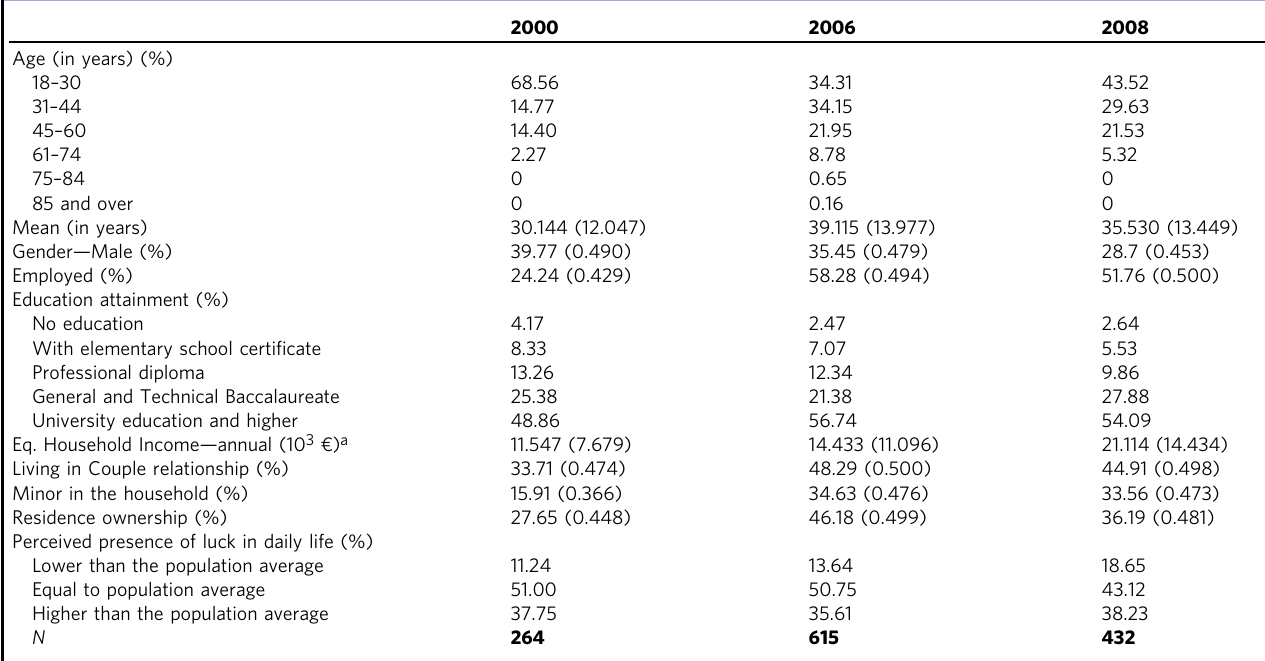
Table 1 Descriptive statistics for explanatory